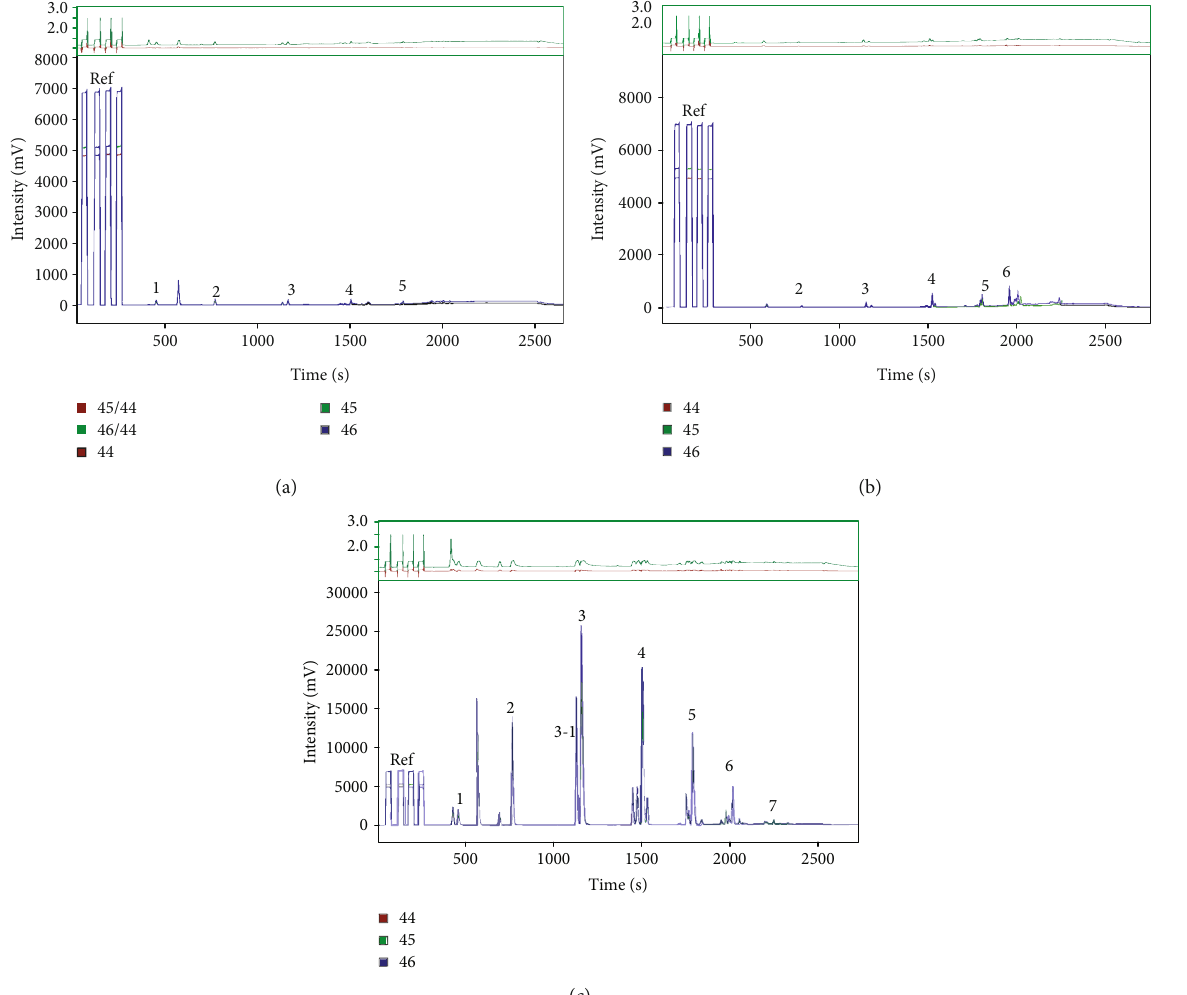
Figure 5: Geological sample analysis of DI, SPME, and SSPE: (a) direct injection of 30 μ L natural gas sample; (b) SSPE extracted for 30 minutes; (c) SSPE extracted for 3 minutes at 20 ° C and then desorbed for 3 minutes at 300 ° C. 1: CH